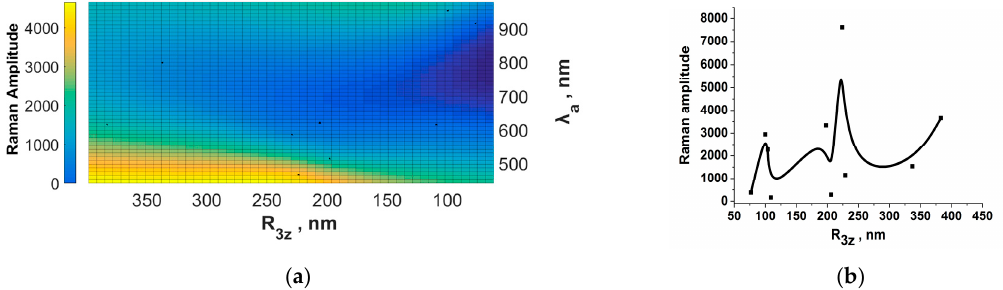
Figure 7. Dependence of signal amplitude on roughness parameters: ( a ) height at three points ( R 3z ) and average profile wavelength ( λ a ); ( b ) SERS signal amplitude vs. height at three points R 3z .